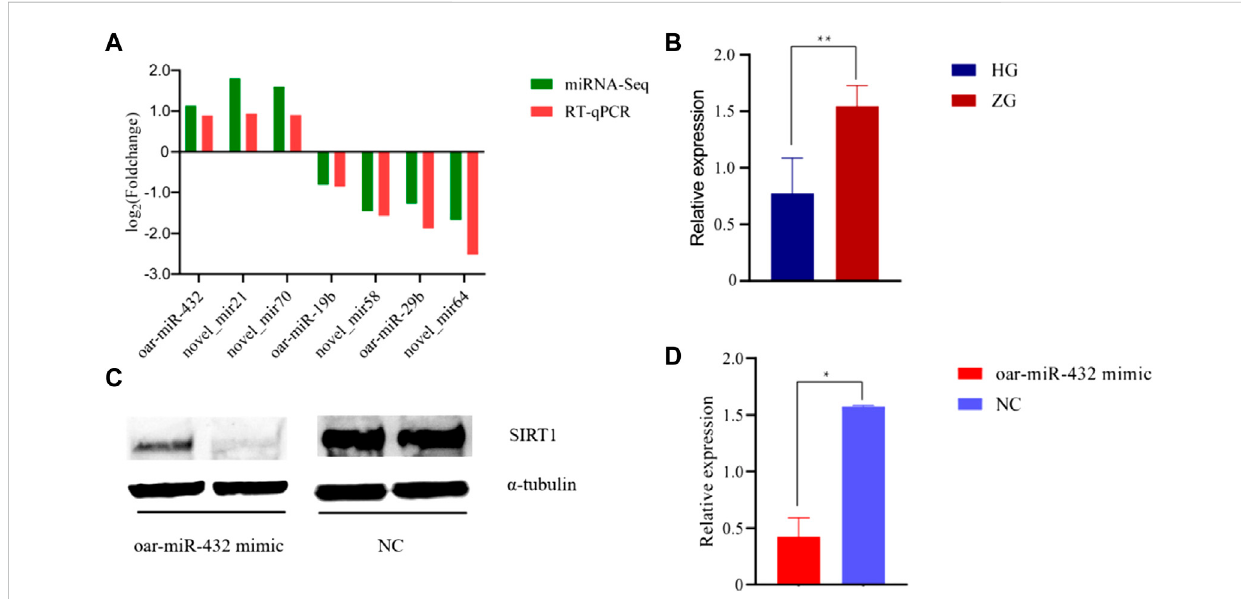
Signi fi cantly enriched Gene Ontology and KEGG for the target genes of DE miRNAs. (A) Some GO terms of target genes of upregulated DE miRNAs for BP, CC, and MF in two groups. (B) GO terms of target genes of downregulated DE miRNAs for BP, CC, and MF in two groups. The x -axis displays enrichment, and the y -axis rep-resents the GO terms. The fi lled colored circles display each statistically signi fi cant GO term. The size of the circles representsthegenenumber. (C) SignalpathwayofthetargetgenesofupregulatedDEmiRNAsintwogroups. (D) Somesignalpathwaysofthetarget genes of upregulated DE miRNAs in two groups. The x -axis displays the enrich-ment factor of the target genes, and the y -axis represents the KEGG pathway. The fi lled colored circles represent each statistically signi fi cant KEGG pathway. The size of the circles represents the number of genes.